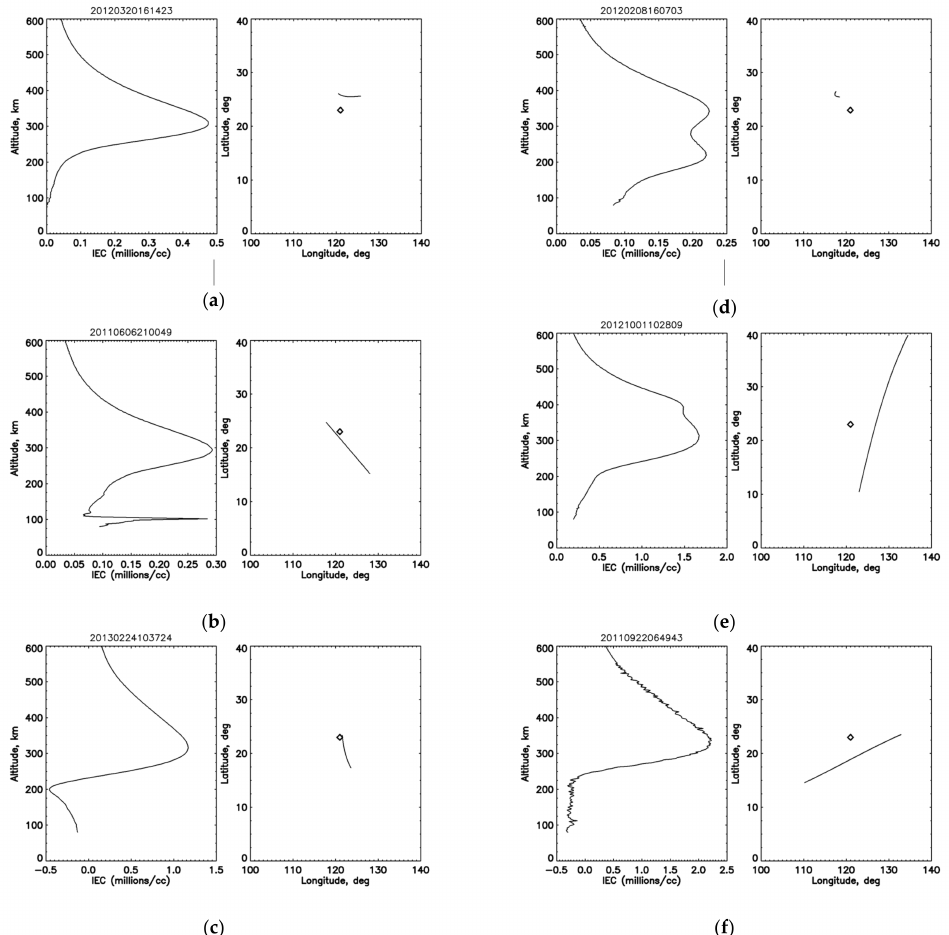
Figure 1. Examples of the height profiles of interpolated electron density (IEC) measured by the technique of GPS radio occultation by the mission FORMOSAT-3/COSMIC above Taiwan: ( a ) pure F2 layer; ( b ) F2 and prominent sporadic E layer; ( c ) F2 and prominent E layer; ( d ) F2 and prominent F1 layer; ( e ) F2 and prominent F3 layer; ( f ) distorted profile. Each panel shows the EC height profile (left) and the trajectory of perigee of RO trace (right). Diamond indicates the location of Hualien ionosonde in